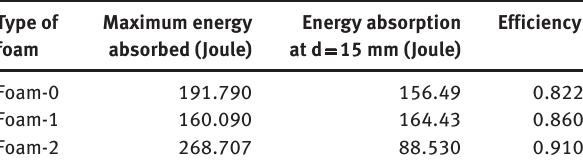
effects of Zn elements on the compressive properties of Al Table 3: Energy absorption result for the different foams. foams were studied and the results were summarized as Type of Maximum energy Energy absorption Efficiency follows: foam absorbed (Joule) at d = 15 mm (Joule) Foam-0 191.790 156.49 0.822 Foam-1 160.090 164.43 Foam-2 268.707 88.530